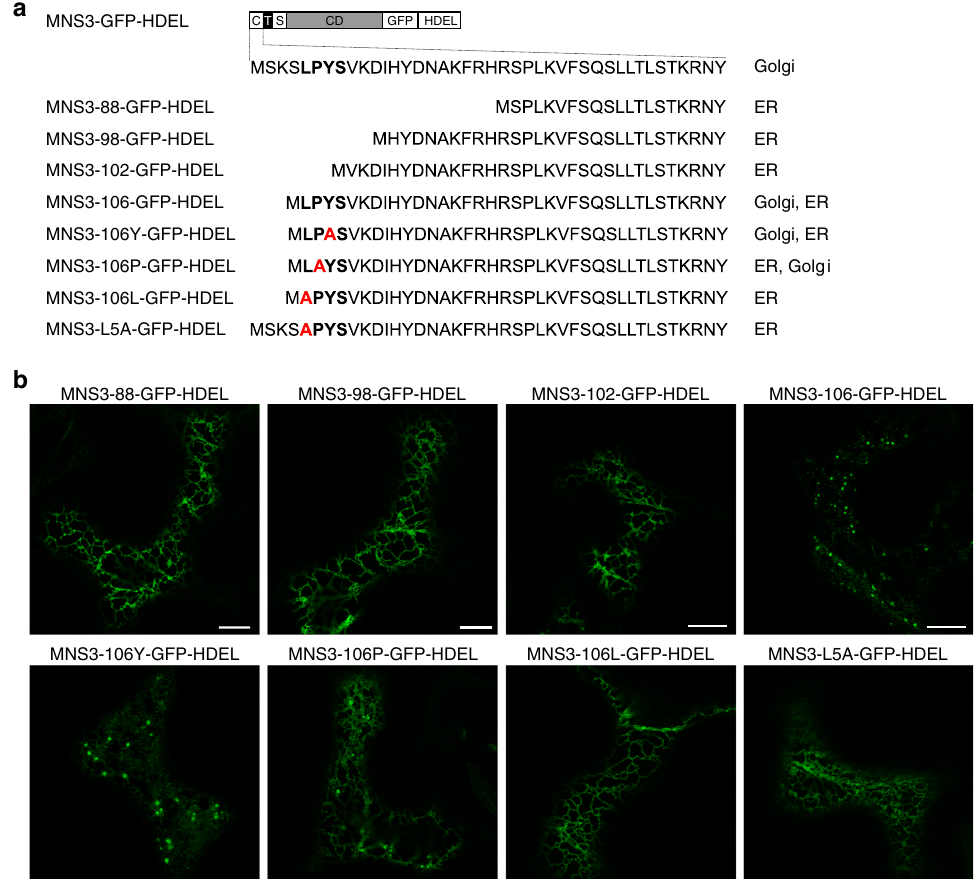
Fig. 7 The cytoplasmic tail of MNS3 contains an amino acid sequence motif that promotes its Golgi retention. a The modular organization of MNS3-GFP- HDEL cytoplasmic tail deletion and mutation constructs and the subcellular localization of fusion proteins in N . benthamiana leaf epidermal cells are shown. The amino acid sequence of the cytoplasmic tail is given. b Confocal images of representative cells showing the subcellular localization of MNS3-GFP- HDEL tail-mutated fusion proteins. Images were acquired 2 dpi. Scale bars = 10 µ